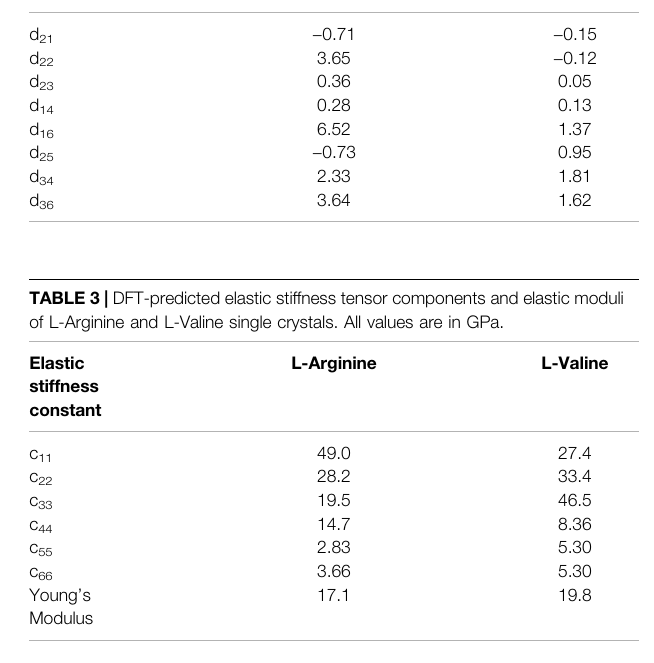
TABLE 2 | DFT-predicted piezoelectric strain tensor components of L-Arginine and L-Valine single crystals. All values are in pC/N. Piezoelectric strain constant